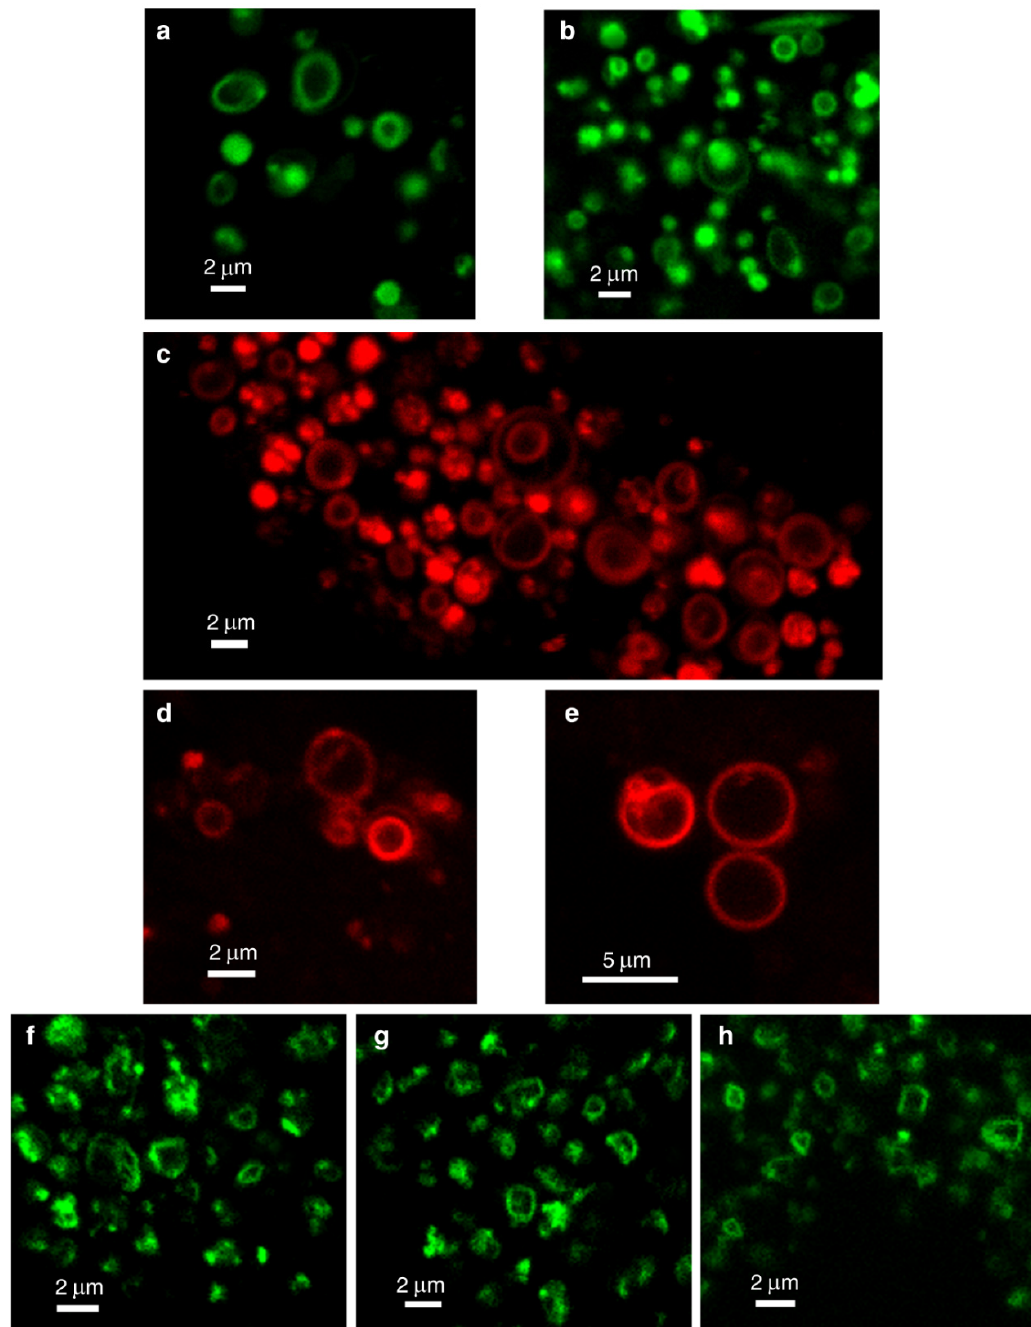
Figure 3. Lysosomal membrane staining with naturally fluorescent lysosomotropic compounds. Vacuolin-1-treated U2OS cells were loaded for 45 min with LysoTracker Green DND-26 (LTG) ( a – b ), daunorubicin (DNR) ( c – e ) or nintedanib (NTD) ( f – h ) and imaged with a confocal Zeiss LSM 710 microscope (×63 magnification). All images are representative of data collected from at least three independent experiments. See also Figure S4.